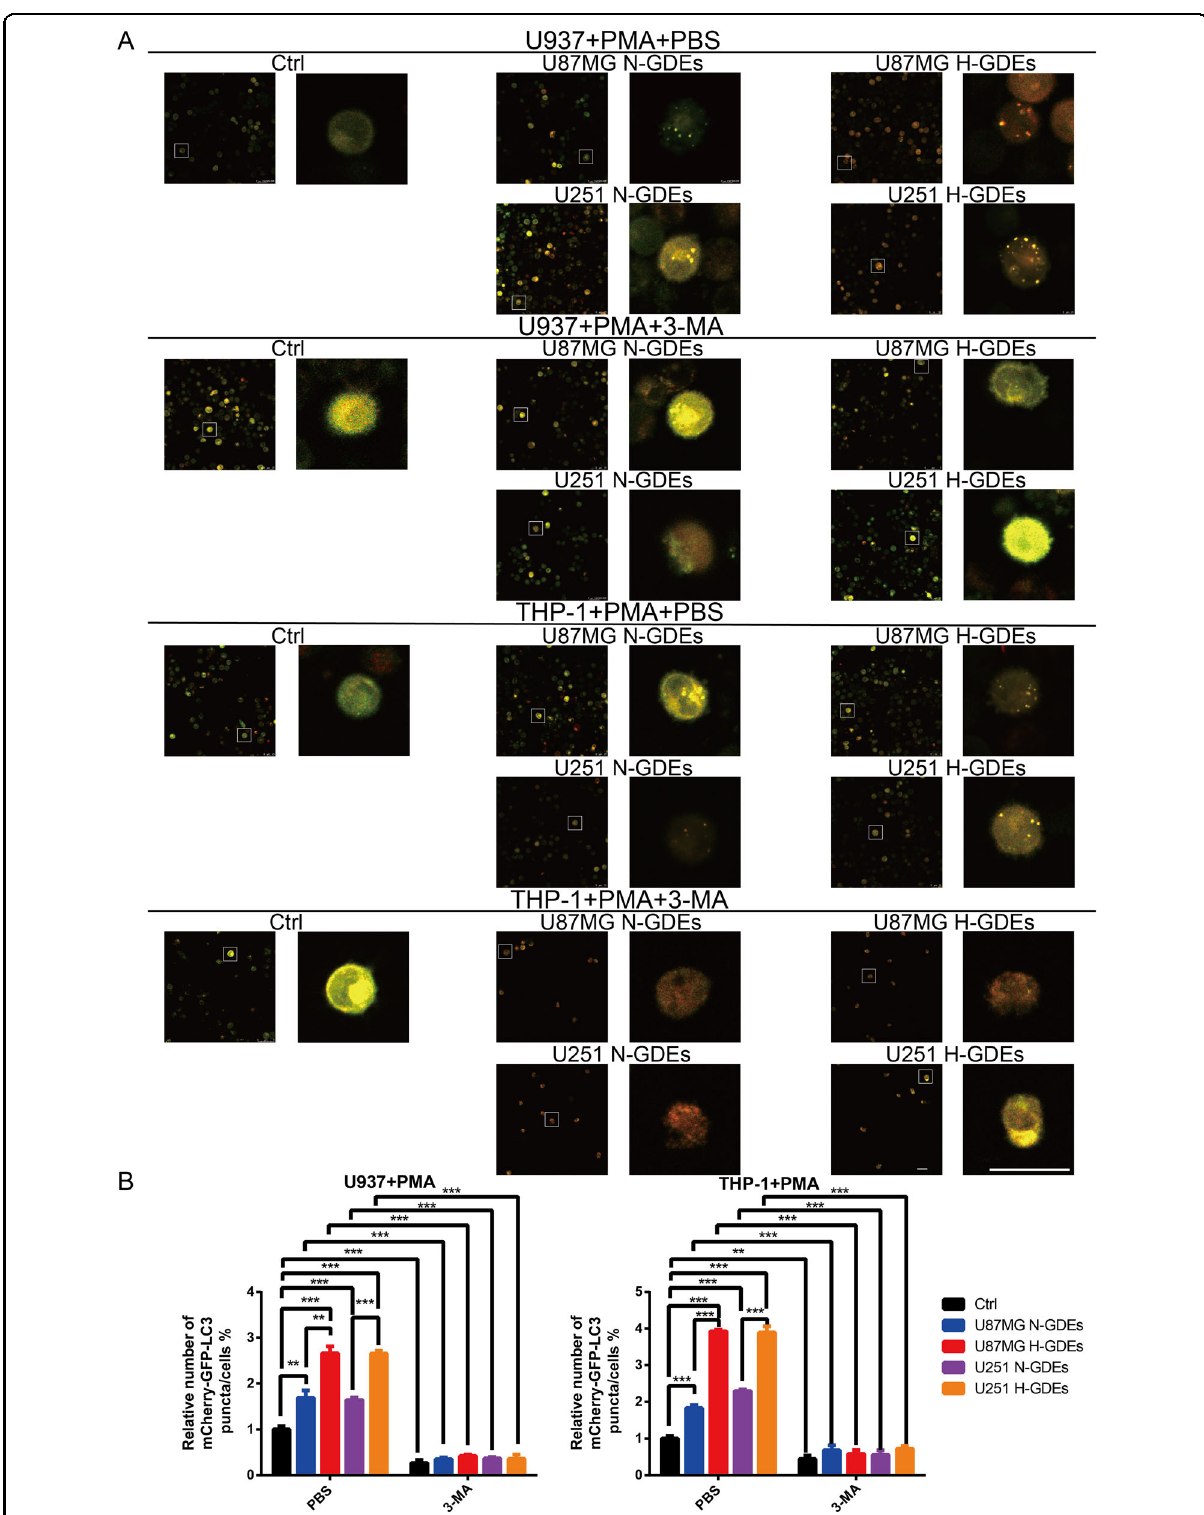
Fig. 1 H-GDEs signi fi cantly induce autophagy in macrophages in vitro. A Human monocyte cell lines U937 and THP-1 were transfected with lentiviruses expressing mCherry ‐ GFP ‐ LC3 plasmid and incubated with PMA (100ng/ml) for 24 h in vitro to induce them to differentiate into macrophages. Then, the macrophages were treated with PBS, N-GDEs, or H-GDEs isolated from the culture supernatants of U87MG or U251 cells. 3-MA was used to inhibit autophagy. Macrophages of different groups were visualized by confocal microscopy. Representative images are shown (Scale bar, 25 μ m). B The number of mCherry ‐ GFP-LC3 puncta in each cell was quanti fi ed. (* P < 0.05; ** P < 0.01; *** P < 0.001; n =